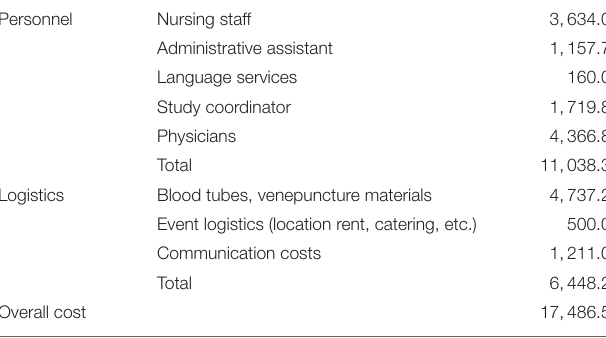
FIGURE 3 | HBsAg quantification compared to duration of treatment induced viral suppression (in